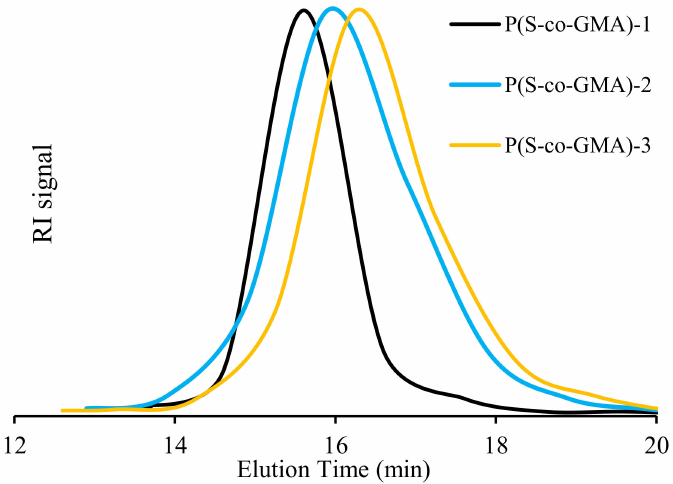
Figure 4. GPC traces for P(S-co-GMA) copolymers synthesized by